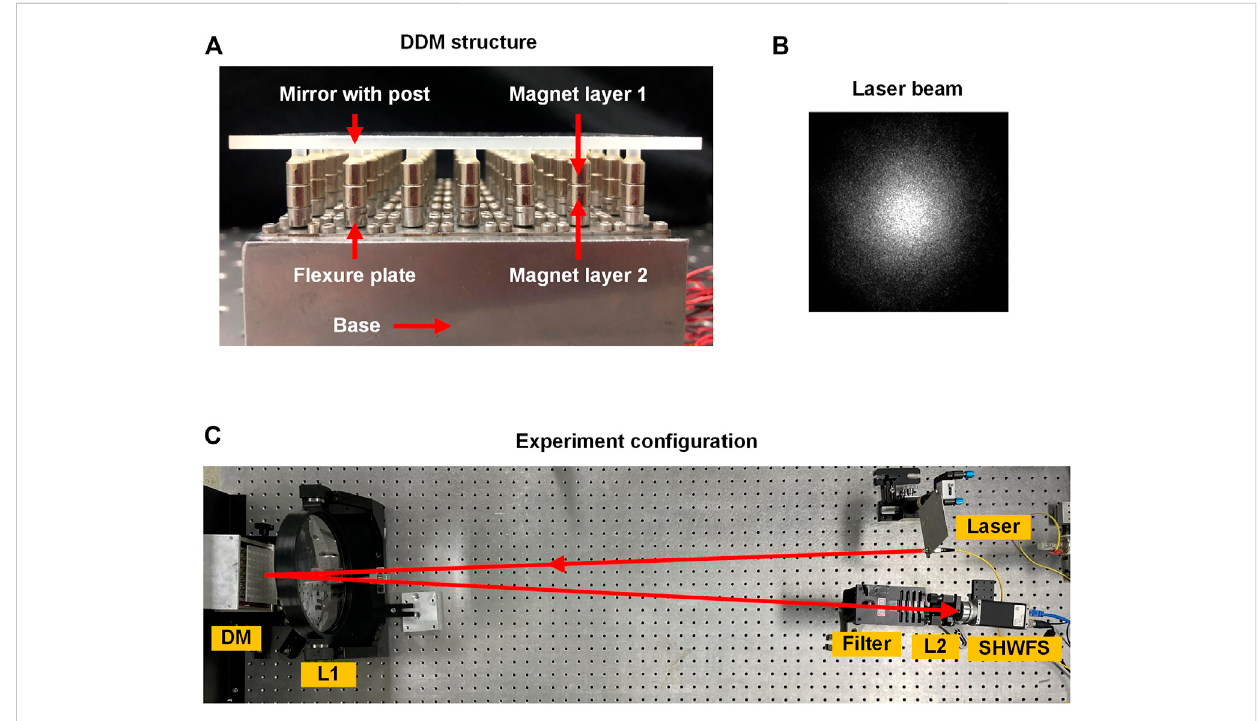
FIGURE 10 Experiment con fi guration of the lab-manufactured DDM. (A) DDM structure. (B) Intensity distribution of the laser beam. (C) Experiment con fi